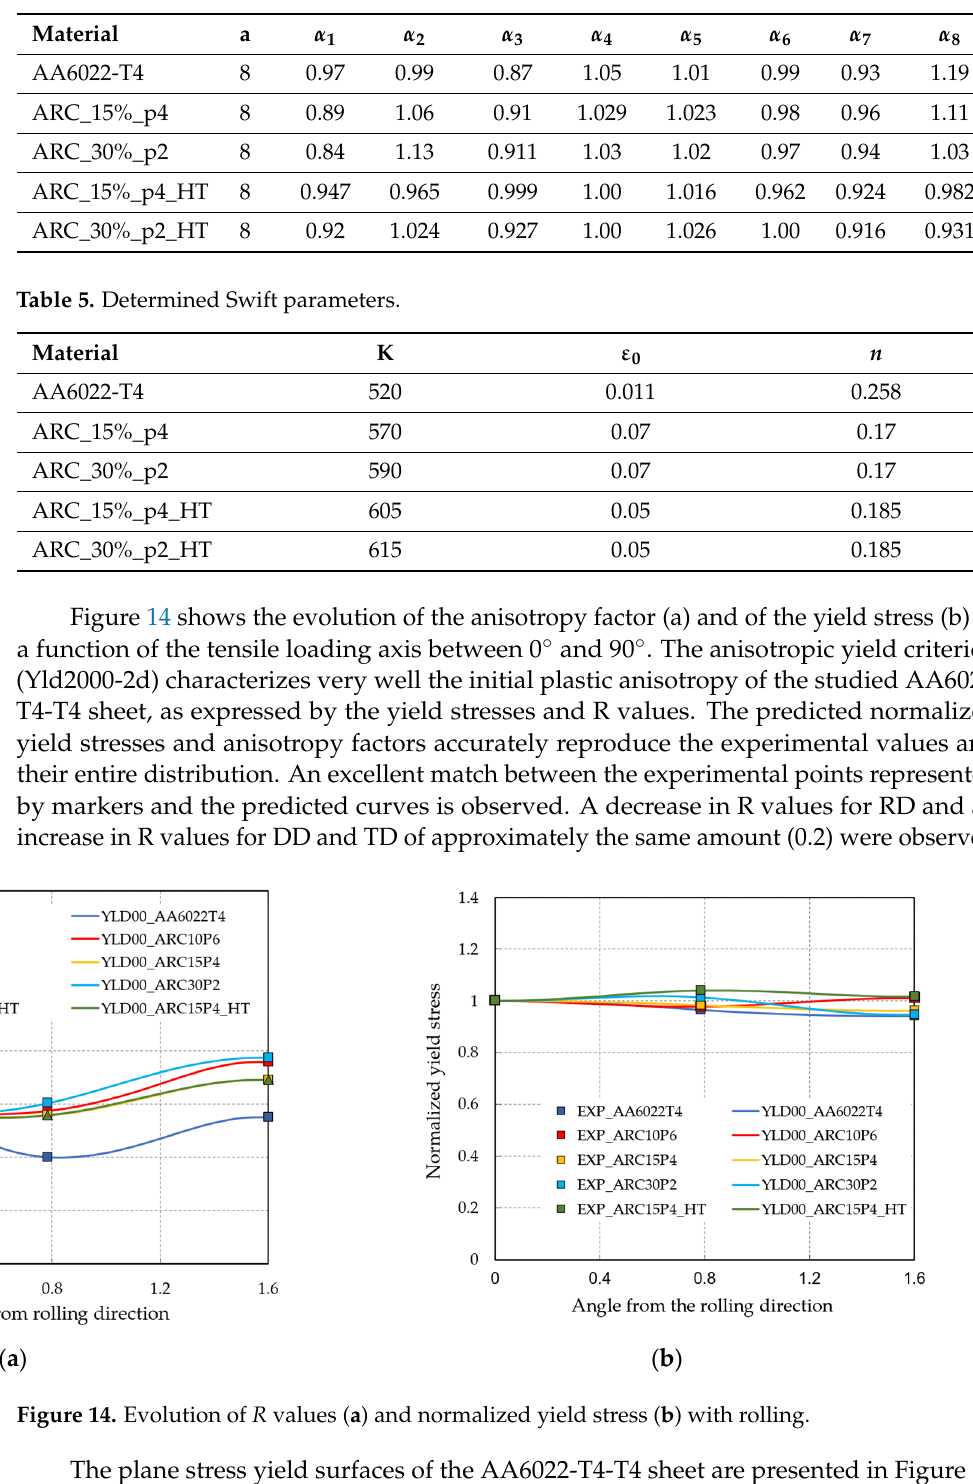
Figure 15. Evolution of the yield surface of AA6022 ‐ T4 ‐ T4 with rolling. Figure 16 shows the experimental forming limits for the AA6022 ‐ T4 ‐ T4 sheet under proportional loading, as well as those simulated with the selected constitutive equations, namely the Yld2000 ‐ 2d yield function with the Voce hardening law and the Swift harden ‐ ing law. To achieve the agreement with the experimental data, the initial value of the M– K geometric defect of 0.9945 and the material strain hardening described by the Swift hardening law were adopted throughout this investigation. The forming limits predicted using the Voce hardening law are underestimated for an f 0 of 0.998, an appropriate value for FCC materials, as suggested by Barlat [26]. An f 0 of 0.9998, chosen to increase the pre ‐ dicted values, results in an under evaluation of the left ‐ hand side of the FLD, whereas the